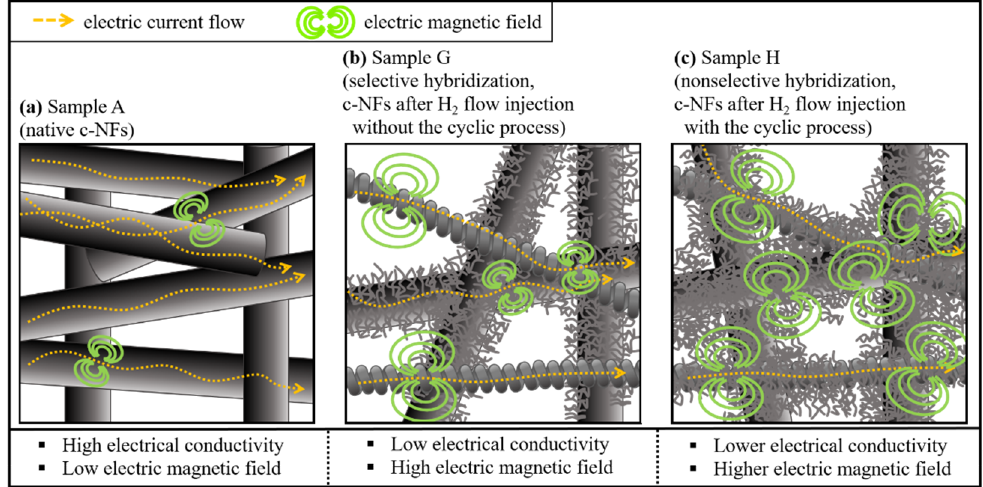
Figure 12. Schematic explaining the enhancement in total SE for the nonselective hybrid formation of numerous tiny CNFs in c-NFs (sample H).